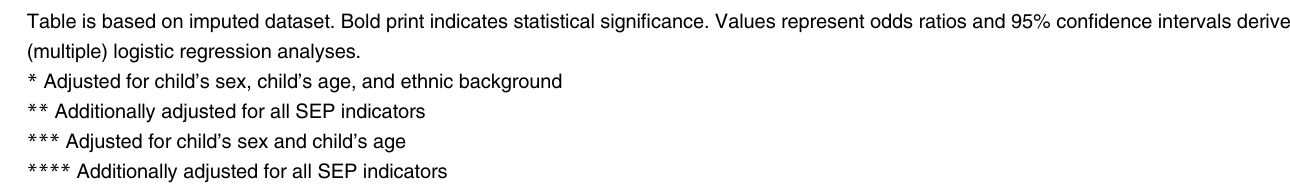
Table is based on imputed dataset. Bold print indicates statistical signi fi cance. Values represent odds ratios and 95% con fi dence intervals derived from (multiple) logistic regression